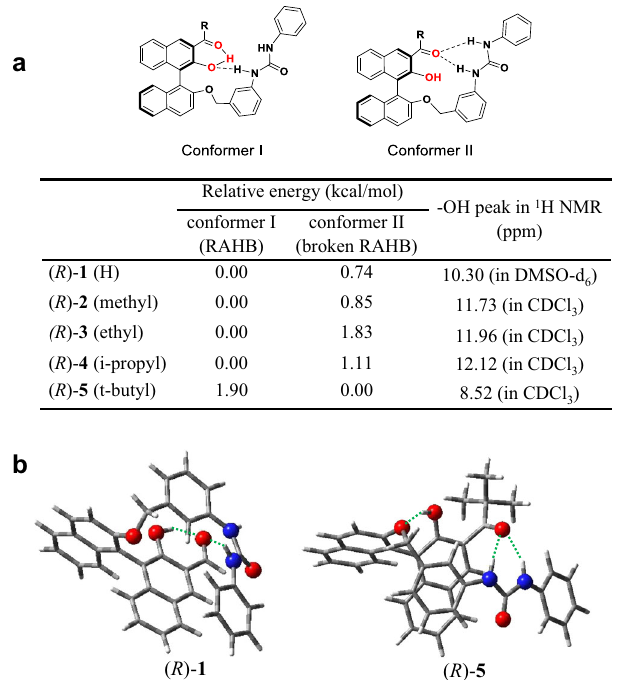
Fig. 3 Calculated structures of ( R )-1 and -5. a Conformers with RAHB (I) or broken RAHB (II), their calculated relative energies, and experimental 1 H NMR chemical shift of the – OH resonances. b Energy-minimized structures showing a RAHB for ( R )- 1 and a broken RAHB with perpendicular carbonyl for ( R )- 5 . Energy calculations based on the crystal structure predicts that ( R )- 5 - L -Phe is more stable than ( R )- 5 - D -Phe by 5.77 kcal/mol, which rationalizes the exceptionally high stereoselectivity obtained in ELLE experiments (see details in Section 8.3 of the Supplementary information).